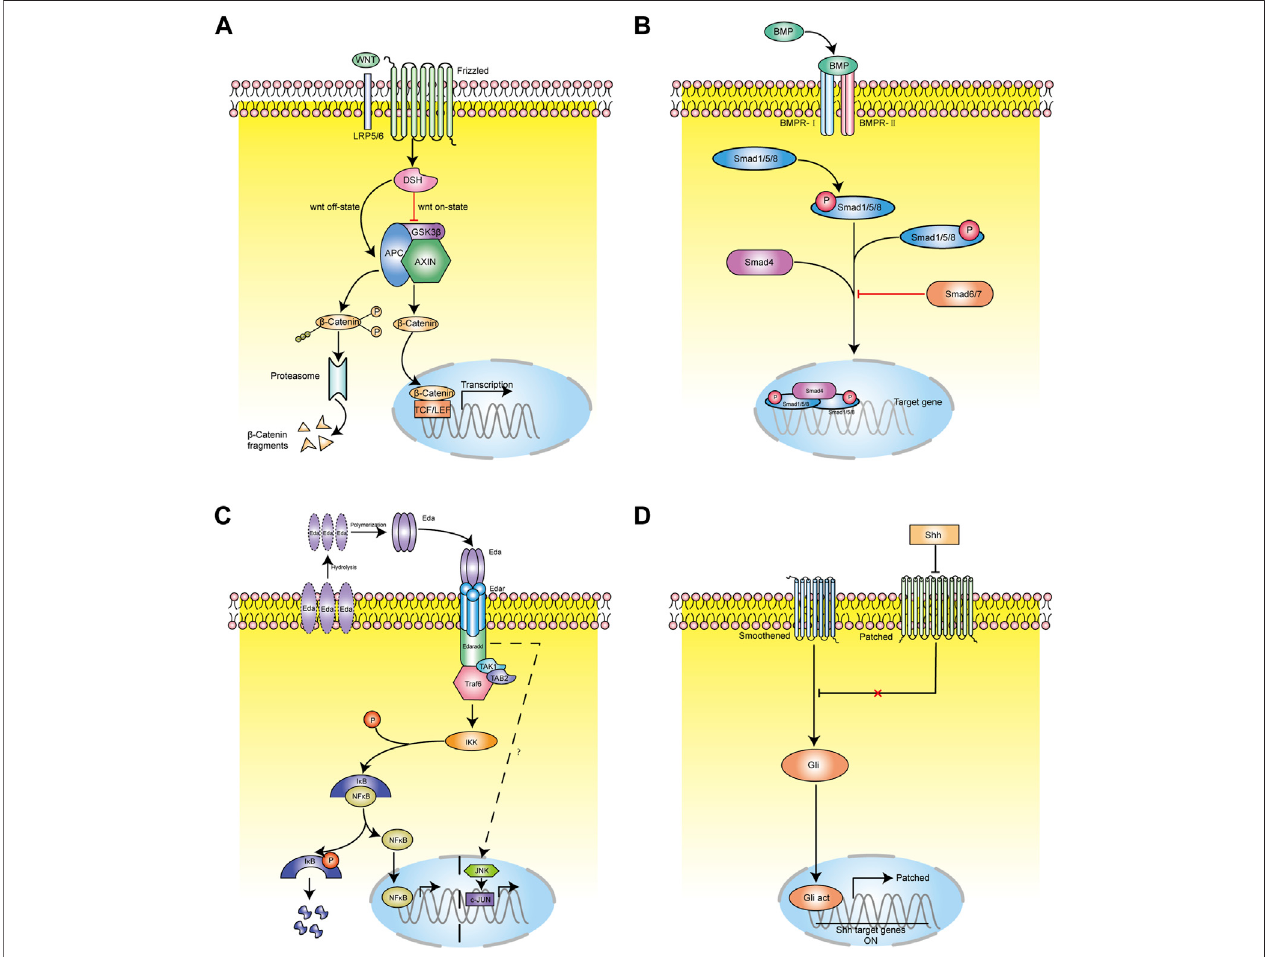
FIGURE 4 | The molecular regulation of hair follicle morphogenesis and cycling. (A) WNT signaling path mode diagram. Schematic drawing illustrating canonical WNT signaling pathway mainly includes WNT protein, cell surface Frizzled receptor family, Dishevelled (DSH) receptor family protein, β -catenin, and axin/GSK-3/APC complex. β -catenin plays a key role in the canonical WNT signaling pathway. (B) BMP signaling pathway mode diagram. The classical BMP signaling pathway is that ligand BMP binds to phosphorylated serine and threonine receptors and is transported into cytoplasm. In cytoplasm, BMP combines with Smad1/5/8 and phosphorylates the C terminal of Smad1/5/8. The phosphorylated Smad1/5/8 combines with Smad4 and transports to the nucleus. (C) EDAR signaling path mode diagram. EDAR signaling pathway ismainly composed ofEDAligand, transmembranereceptor EDAR(includingEDAA1and EDAA2subtypes),and intracellular binding protein EDARARR. (D) SHH signaling path mode diagram. Ptch bindstoSmo toinhibit Smo activity. In thepresence ofHh, thebinding ofPtch1toHh protein eliminates the inhibitory effect on Smo, and Smo transmits signals to downstream Gli transcription factors through a complex transduction process.